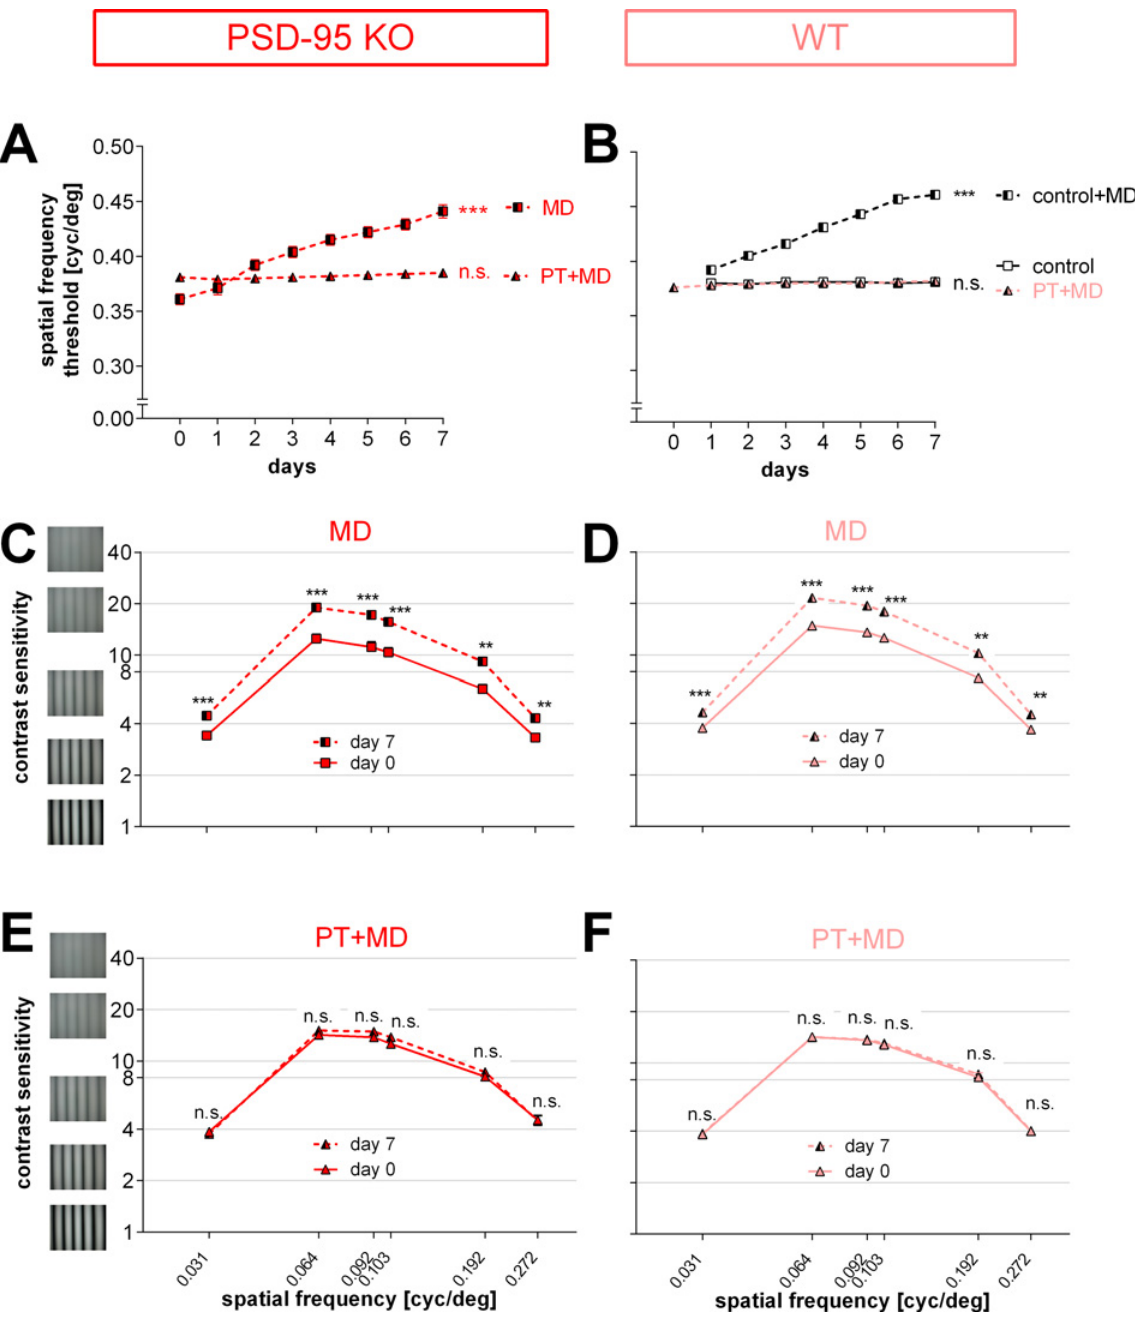
Fig 3. The experience-enabled enhancement of the optomotor reflex of the open eye after monocular deprivation (MD) was compromised in both PT-lesioned PSD-95 WT and PSD-95 KO mice. In contrast, enhancements of spatial vision were present in nonlesioned PSD-95 WT and PSD-95 KO mice. (A, B) Spatial frequency threshold of the optomotor response of the open eye in cycles per degree (cyc/deg) plotted against days after MD. After 7 days of MD, nonlesioned PSD-95 KO mice (A) as well as sham-treated control mice (B; data from Greifzu et al., 2011) showed a significant increase in the spatial frequency threshold of the optomotor reflex of the open eye. This experience-enabled increase was abolished by a PT in S1 (A, B). (C-F) Contrast sensitivity thresholds of the optomotor reflex of the open eye at 6 different spatial frequencies before (day 0) and 7 days after MD. For both nonlesioned PSD-95 KO (C) and PSD-95 WT mice (D), there was an increase in contrast sensitivity after 7 days of MD. After PT, this experience-enabled increase was absent in both groups (E, F).